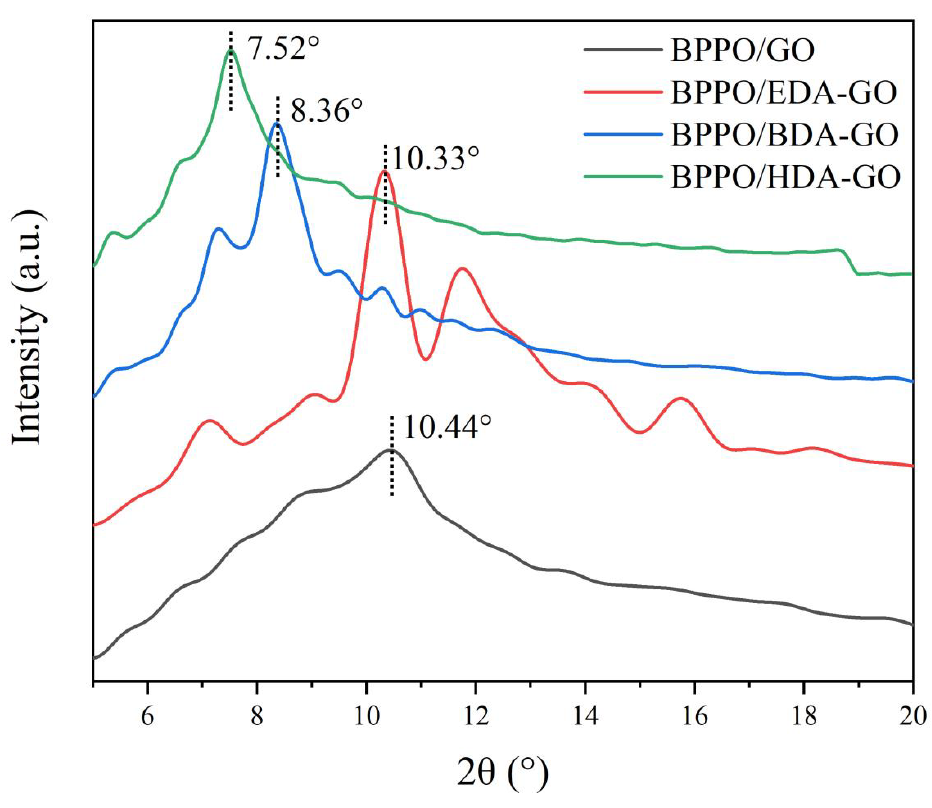
Figure 3. XRD patterns of BPPO/GO and Ax-GO-modified membranes.